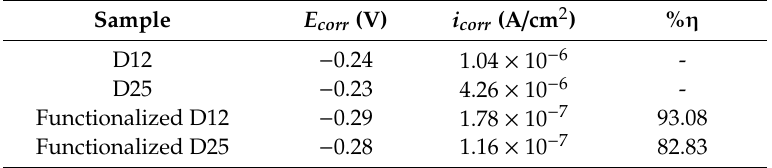
Table 2. Electrochemical parameters obtained from polarization curves in Figure